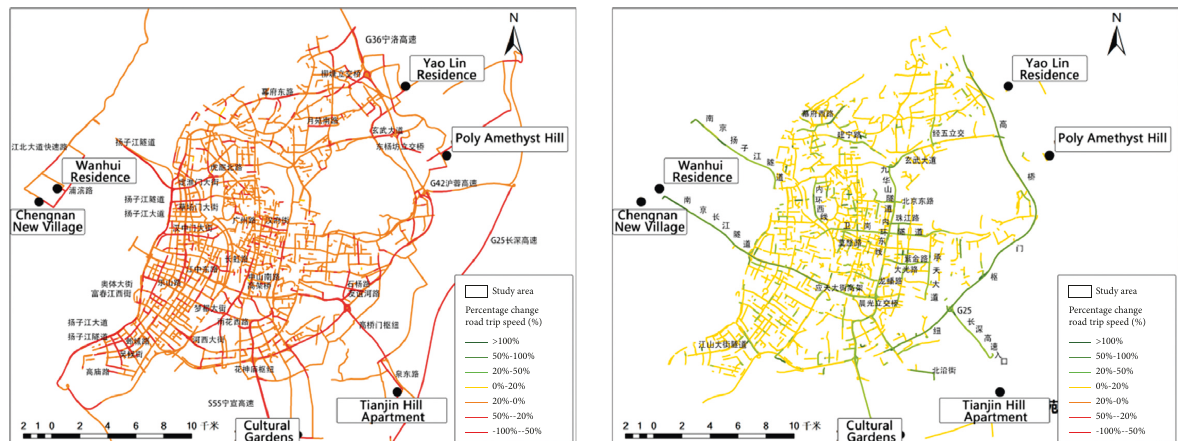
Figure 9: Spatial distribution of trip speed variation by road section in the morning peak on January 25